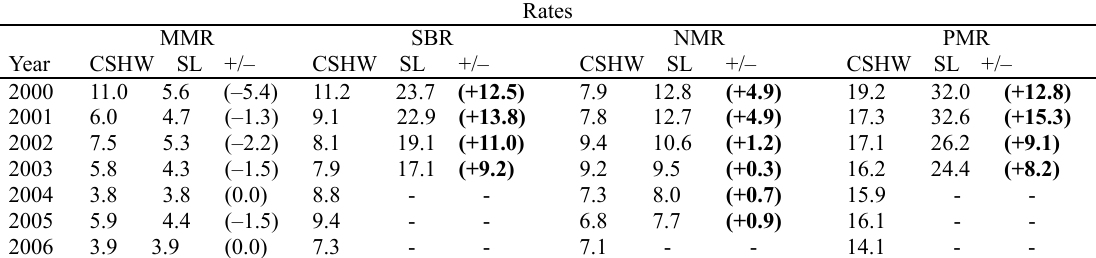
Table 3. Service outcome rates of CSHW in comparison to the national figures of Sri